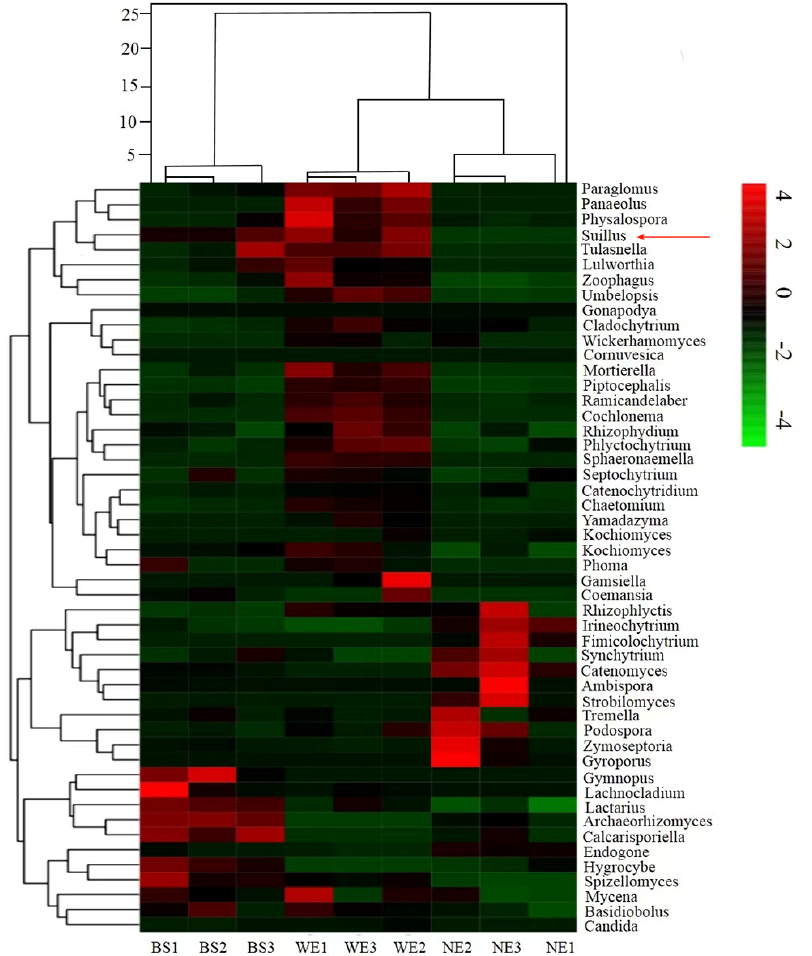
Figure 6. Correlationship of the most fungal communities in soil with ectomycorrhizal–fungus inoculation (WE), soil without ectomycorrhizal–fungus inoculation (NE), and bulk soil (BS)at genus level; arrows indicate position of Suillus